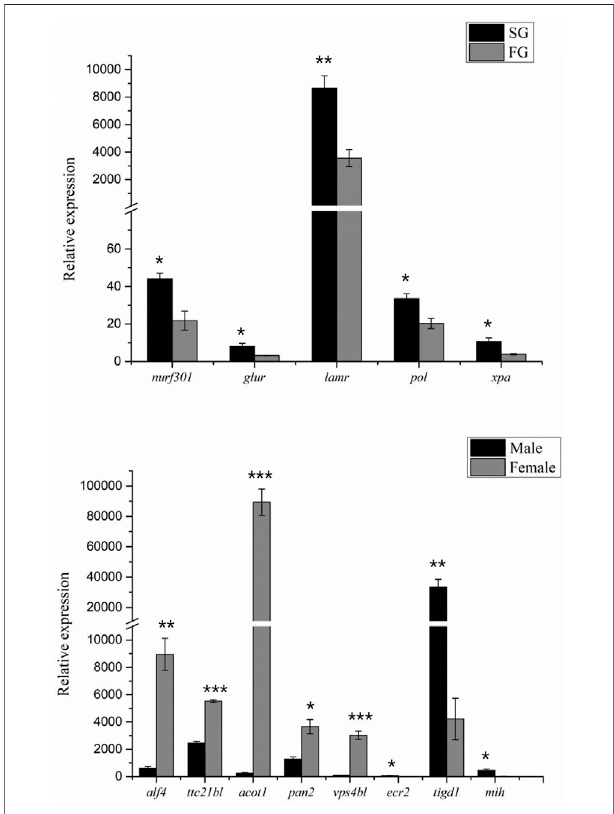
FIGURE 6 | qPCR validation of growth and sex candidate genes. “ ***, ” signi fi cant at p < 0.001. “ **, ” signi fi cant at p < 0.01. “ *, ” signi fi cant at p < 0.05.